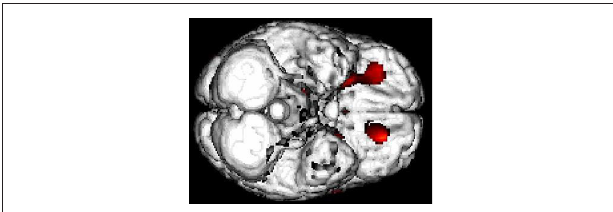
FIGURE 1 | An inferior view of the brain showing a bilateral activation of the orbitofrontal cortex in response to the presentation of sexually arousing film clips (unpublished figure from study by Redouté et al., 2000) .